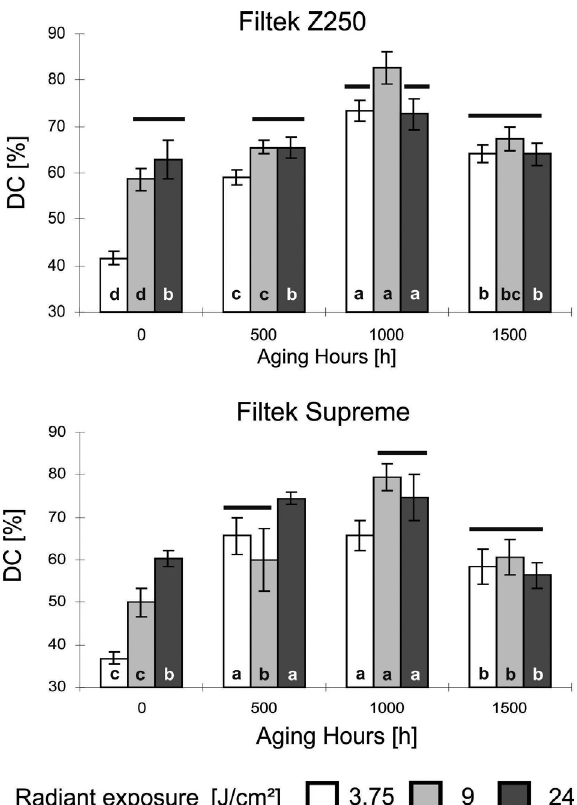
Figure 3- Degree of conversion for Filtek Z250 (top) and Filtek Supreme (bottom) at different radiant exposures and UV accelerated aging hours. Columns under the same horizontal line indicate no differences between radiant exposure for each period of aging hours. Different lowercase letters indicate differences between aging hours within each radiant